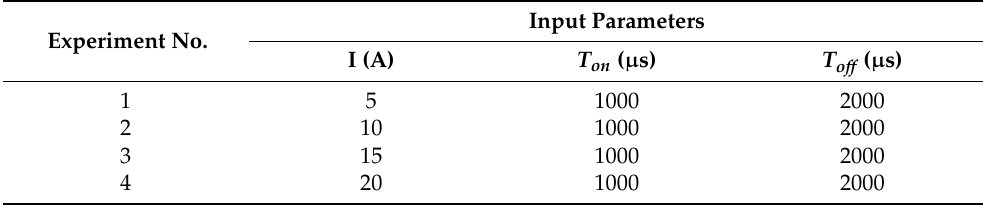
Table 5. Different sets of input parameters. Experiment